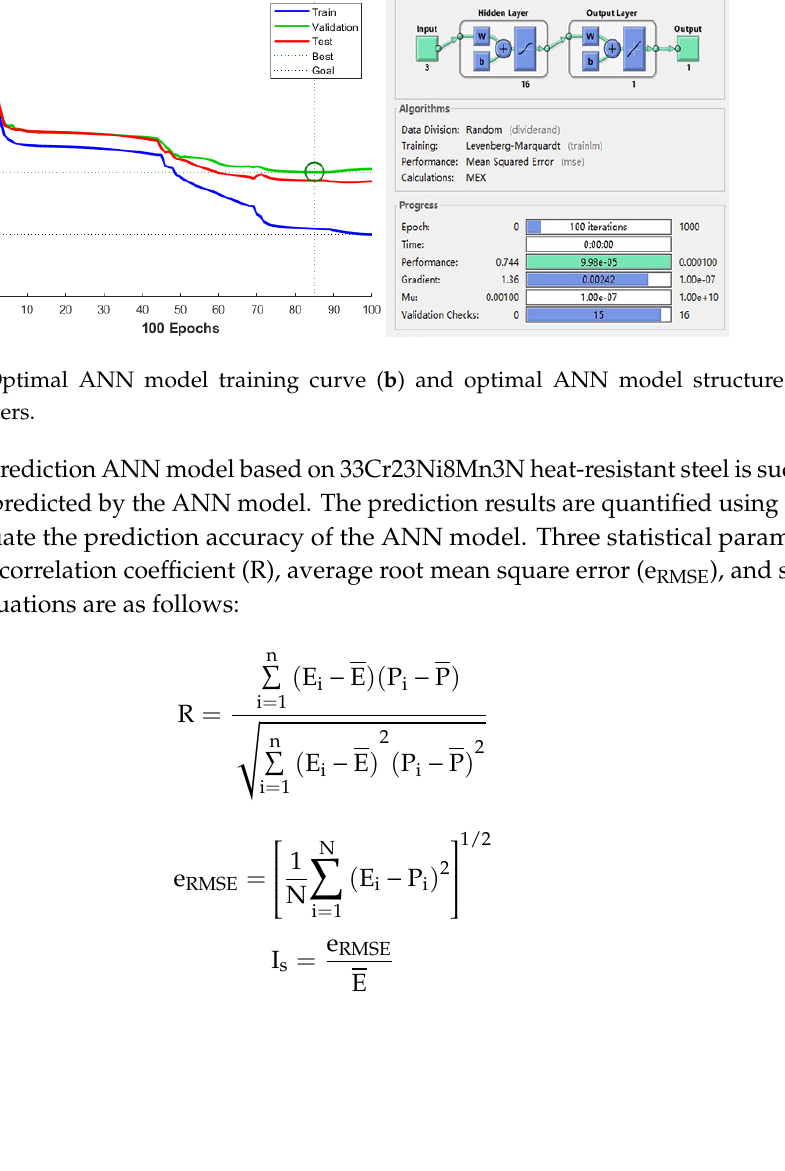
Figure 4. Effect of number of hidden layer neurons on prediction accuracy of the dynamic recrystallization (DRX) model.